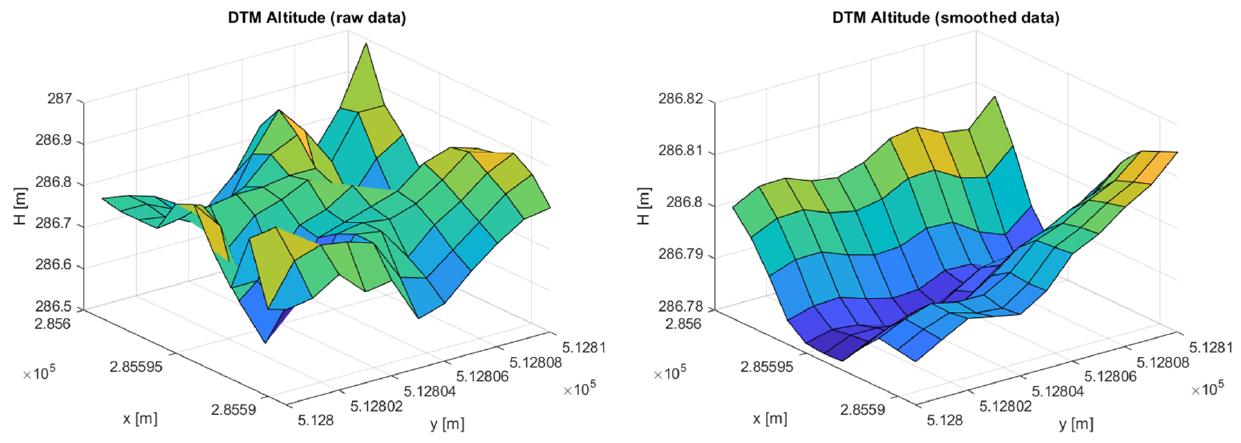
Figure 9. Altitude raw and smoothed data (10 × 10 m section).